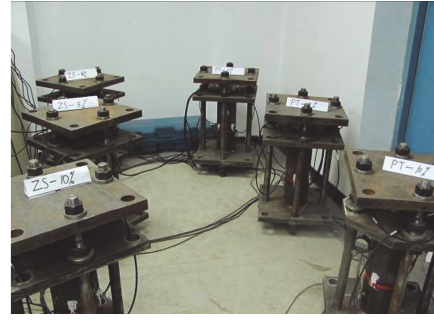
Figure 8: Experimental testing devices.